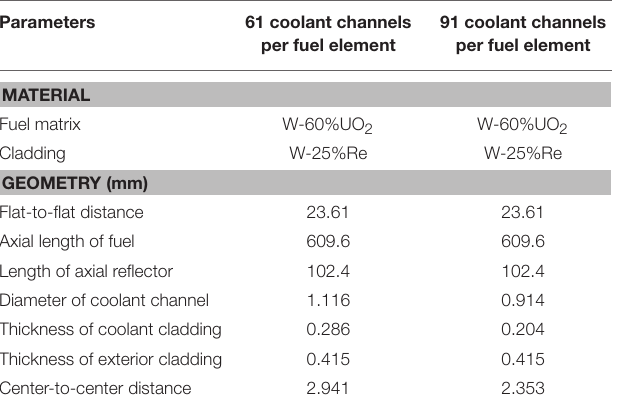
TABLE 2 | Design parameters of the fuel element.